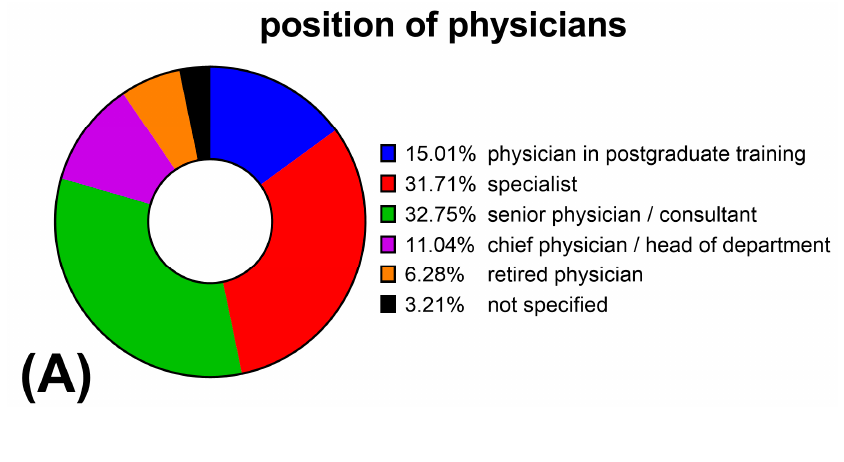
Figure 2. Representation of the distribution of the age of all survey participants (n = 2898) in absolute numbers in the six different categories as a histogram. The number of participants in each age group is plotted at the top of the bars.